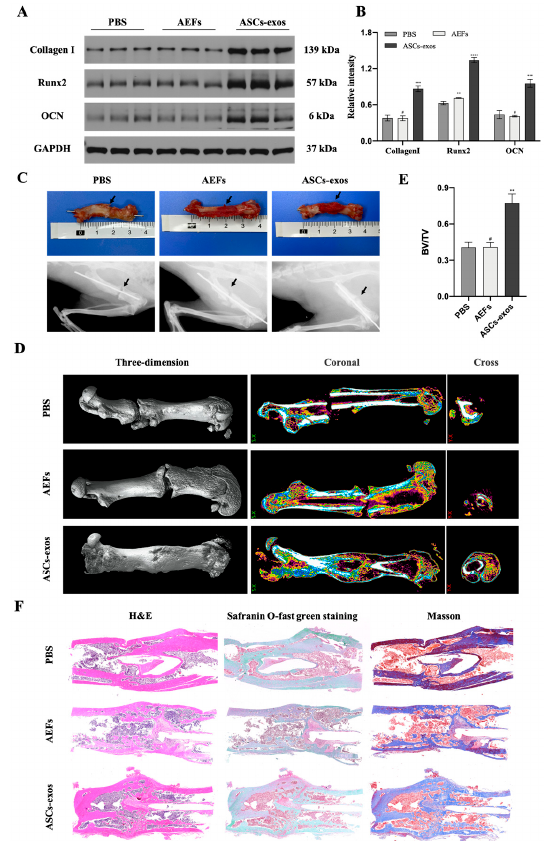
Figure 4. ASCs-exos accelerate fracture healing in T2DM rat models. ( A , B ) The protein levels of Runx2, collagen I and OCN at the fracture site treated with PBS, AEFS or ASCs-exos for 28 days were measured via Western blotting. ( C ) Representative digital images and X-ray images of fracture healing 28 days after surgery between PBS, AEFS and ASCs-exos groups. ( D ) Representative 3D, coronal and cross micro-CT images of fracture sites 28 days after surgery between PBS, S and ASCs-exos groups. ( E ) The statistical analysis of BV/TV according to micro-CT images 28 days after surgery among different groups. ( F ) Histology examination including H&E, safranin O-fast green and Masson staining of the femurs. Data are presented as the mean ± SD, and all experiments were repeated three times. ** p < 0.01, *** p < 0.001, **** p < 0.001, # p >